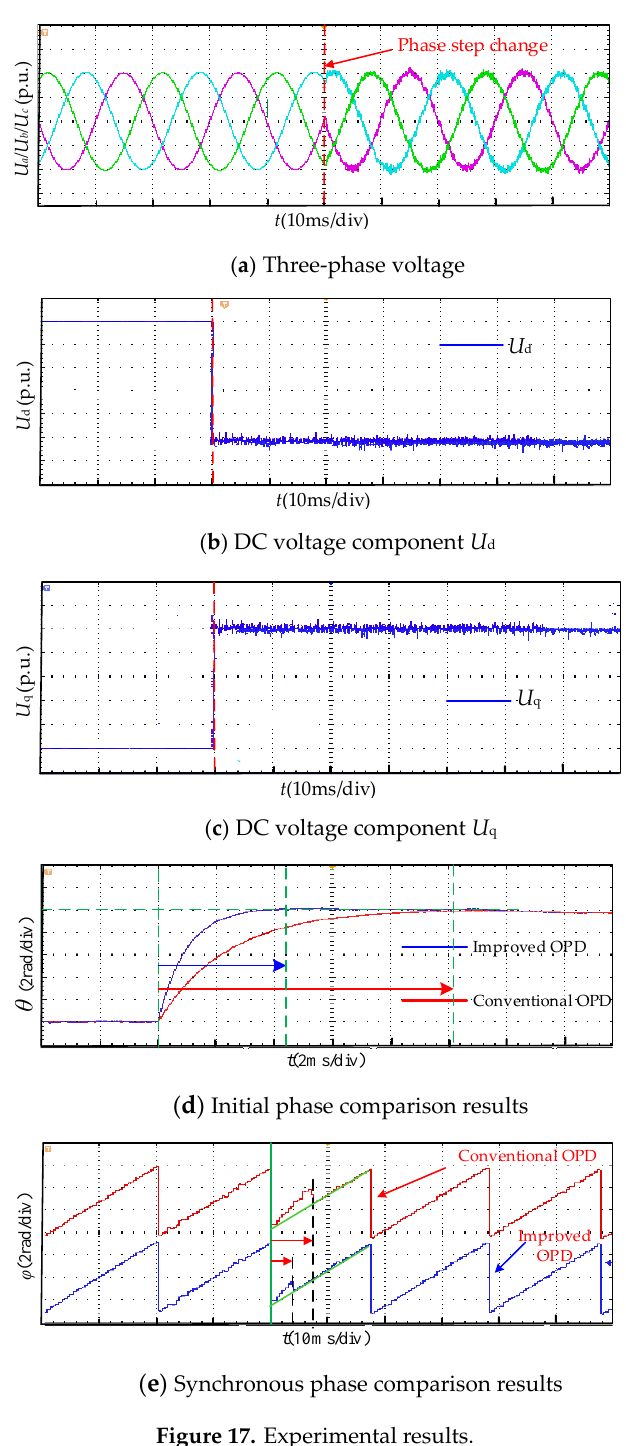
Table 2. Comparison result of dynamic response time (ms).